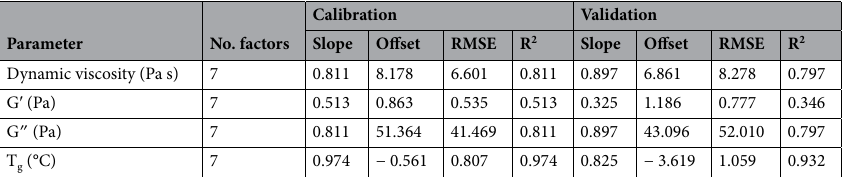
Table 3. Statistical results of the rheological parameters and T g prediction using the partial least square regression based on the chemical composition.